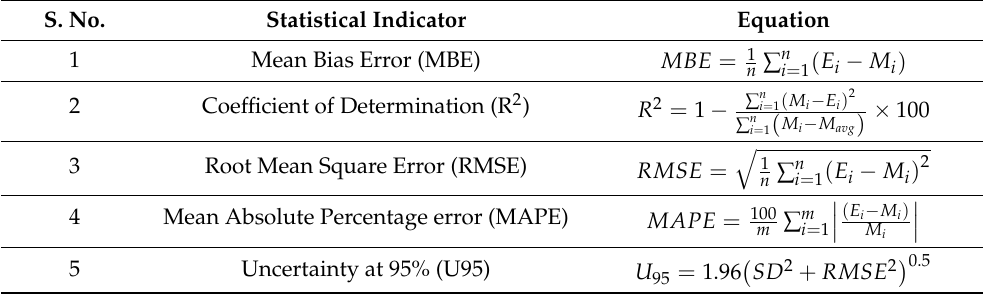
Table 2. Mathematical equations of Statistical indicators employed in the current study. S.